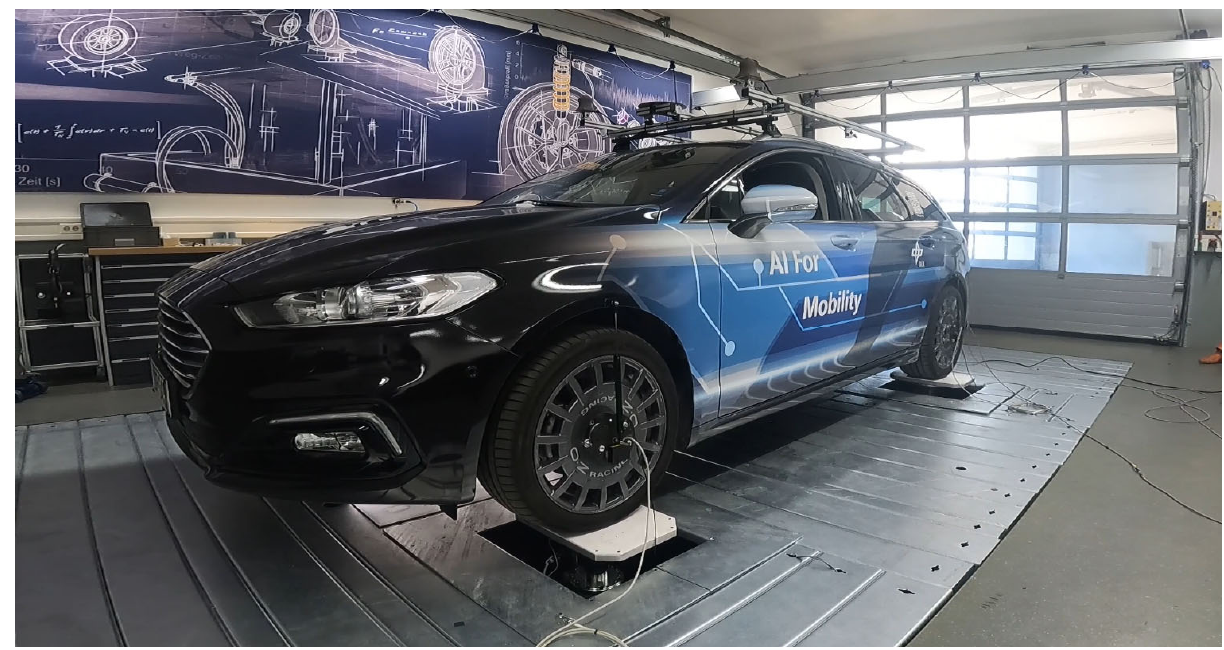
Figure 4. AFM experiments on a vertical dynamics test rig.